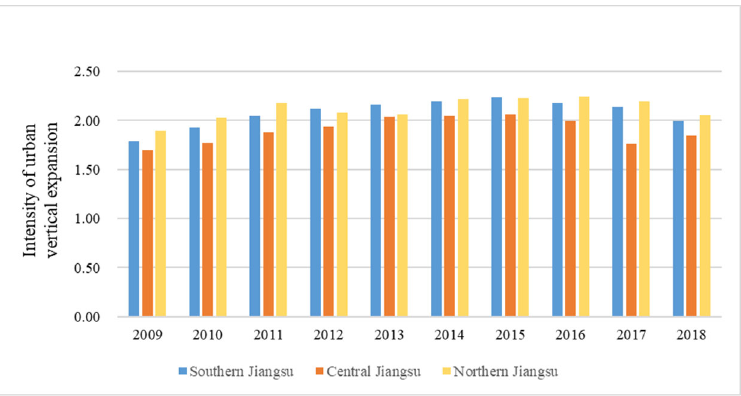
Figure 4. Urban vertical expansion intensity in Jiangsu Province. (Classified by regional difference).